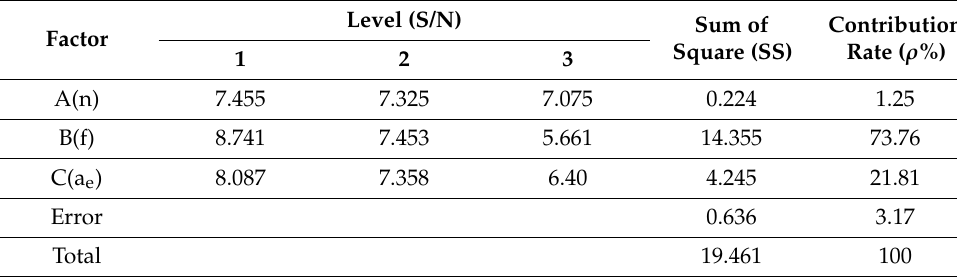
Table 5. Laser-assisted milling (Si 3 N 4 ) surface roughness variance